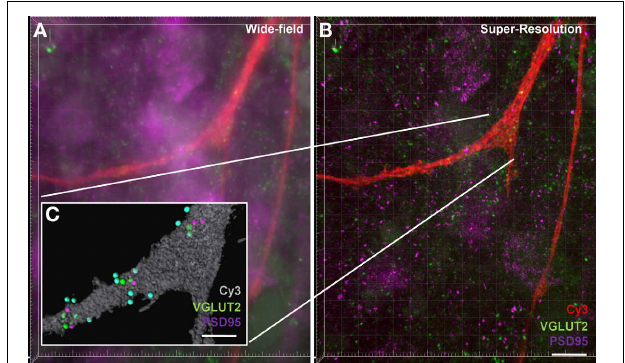
filament method, P = 0 . 41. Presynaptic VGLUT2: 8 . 25 ± 3 . 04